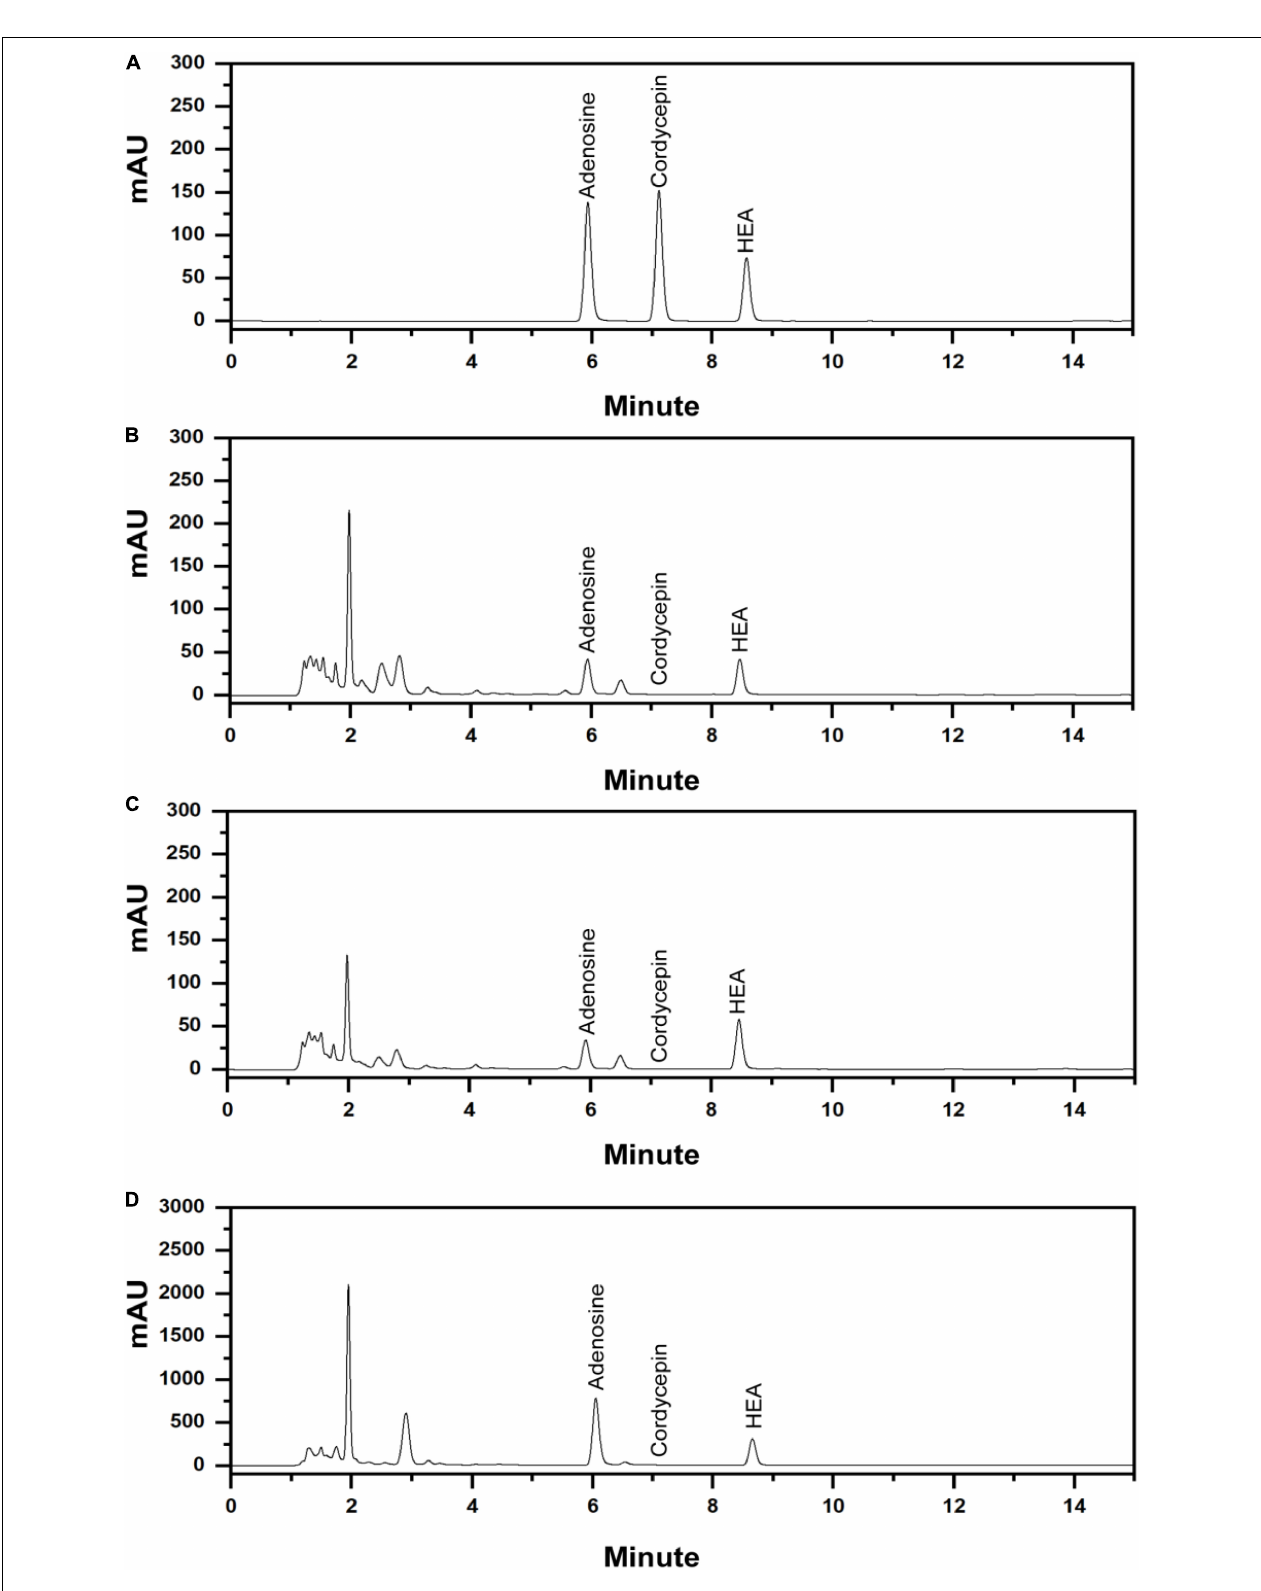
FIGURE 7 | High-performance liquid chromatography (HPLC) chromatograms of (A) mixed standards of adenosine, cordycepin, and N 6 -(2-hydroxyethyl)-adenosine (HEA) and (B) the extract of the coremium; (C) the extract of the sclerotium; and (D) the extract of the mycelia of C. cicadae AH10-4.